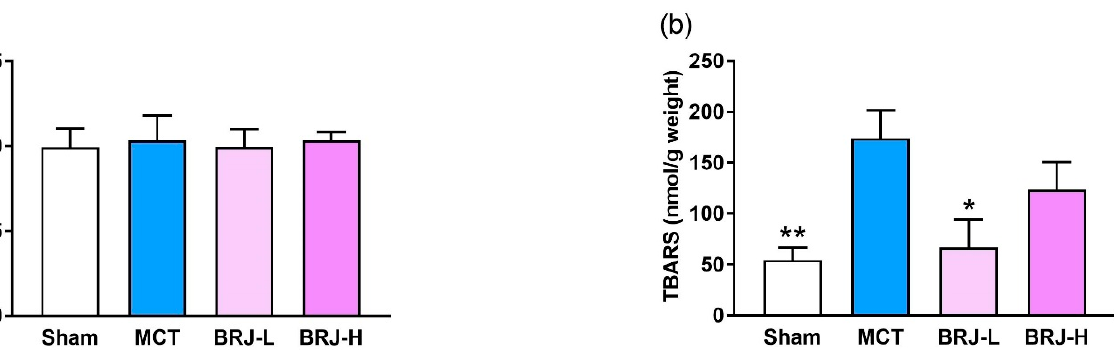
Figure 5. Effects of BRJ supplementation on oxidative stress in MCT-injected rats. ( a ) plasma TBARS, ( b ) RV TBARS. Each column and bar represent the mean ± SEM values of 6–9 experiments. One- way analysis of variance with the Holm–Sidak post hoc test was performed to determine the signif- icance; * p < 0.05 and ** p < 0.01, compared to the MCT group. Abbreviations: BRJ, beetroot juice; MCT, monocrotaline; RV, right ventricle; TBARS, thiobarbituric acid reactive substances; BRJ-L, low-dose beetroot juice; BRJ-H, high-dose beetroot juice.